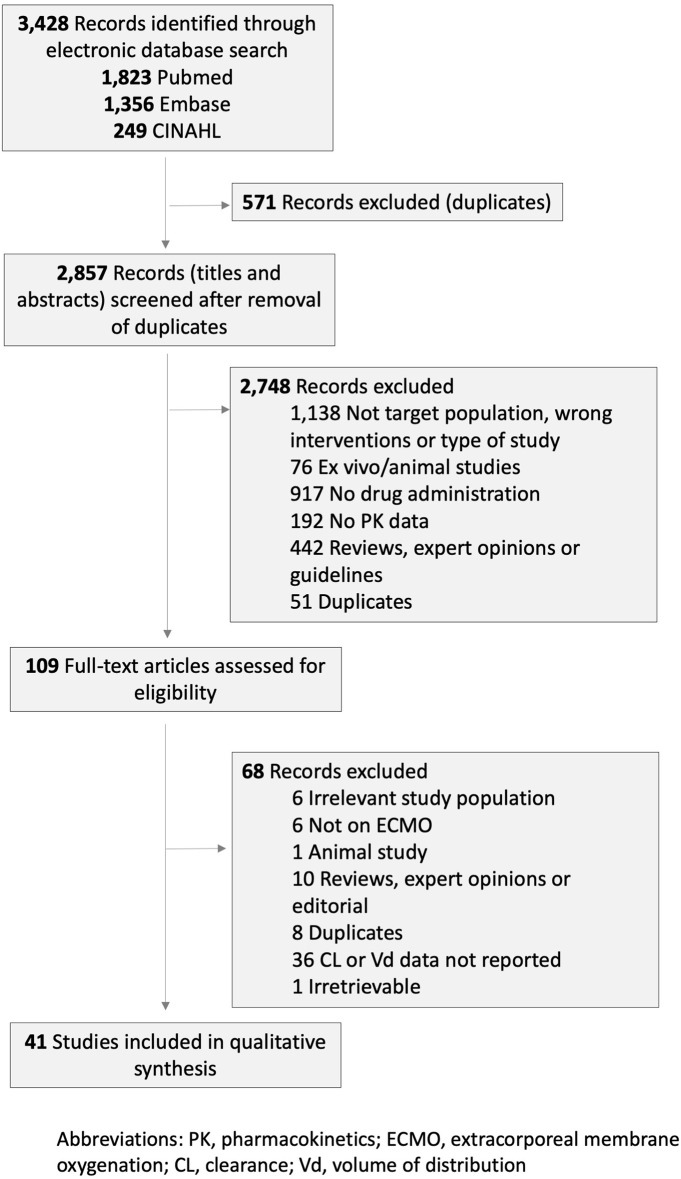
PRISMA diagram of study selection.